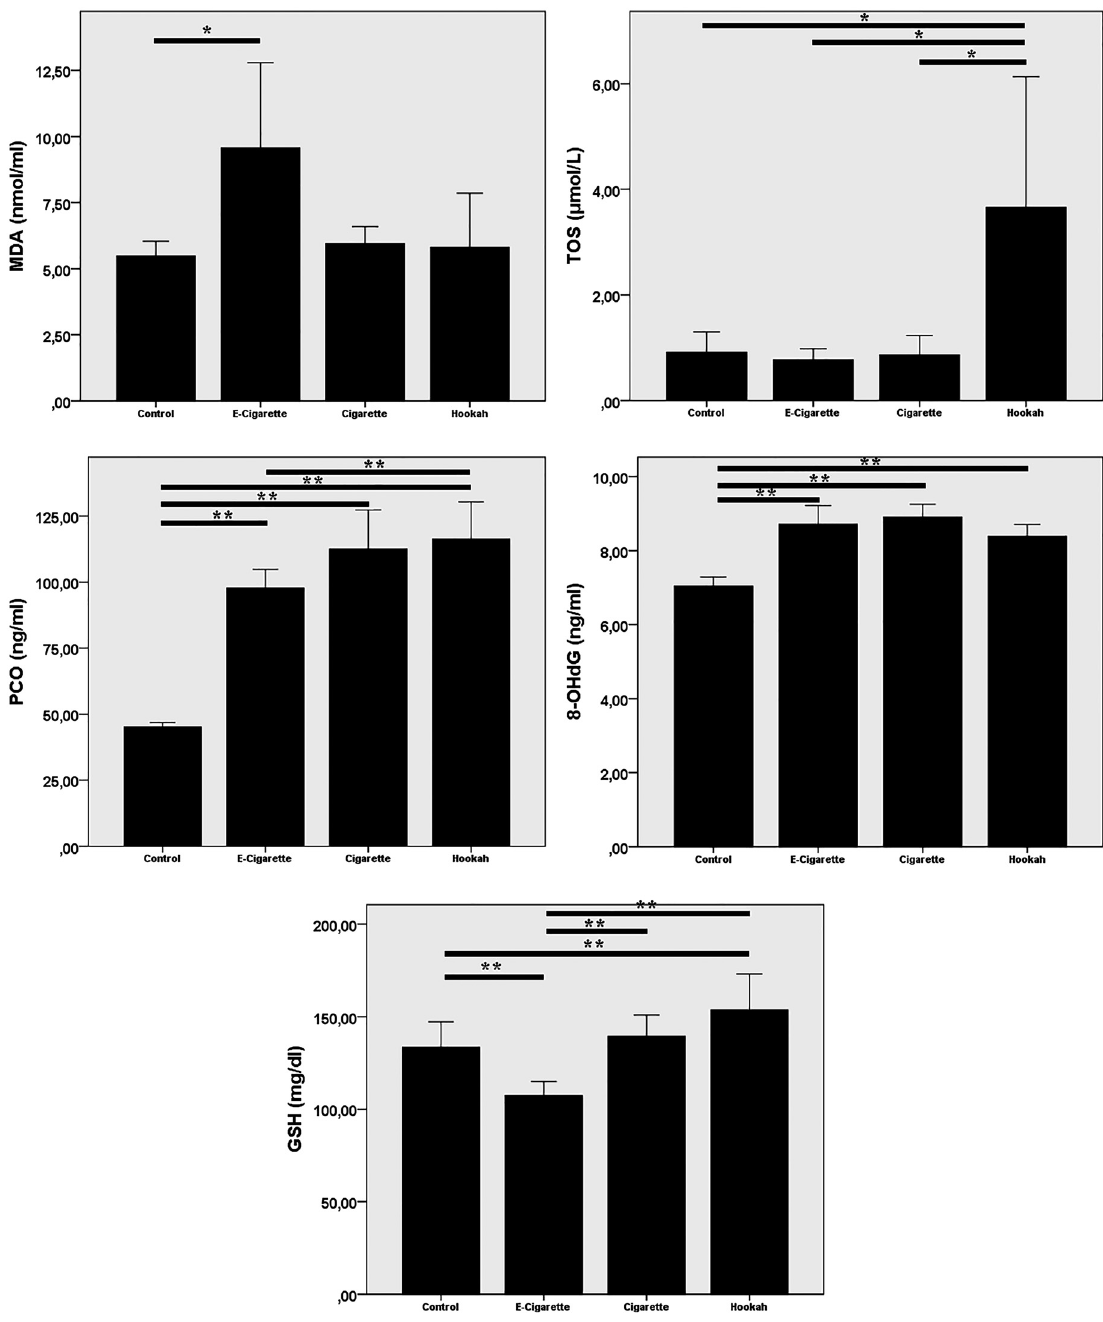
Figure 2: Redox parameter graphs Bargraphsshowingthequantificationinvariousunits ± SDofmalondialdehyde(MDA),totaloxidantstatus(TOS),proteincarbonyl(PCO),DNA damage marker (8-OHdG), and reduced glutathione (GSH) parameters measured in the study groups (ANOVA, posthoc Bonferroni test, *p<0.05; hydrogen peroxide form in the tar phase causes oxidative damage in the cellular DNA at the same time [18]. It has also been reported that the same condition is valid for both e-cigarette [9] and hookah [24].